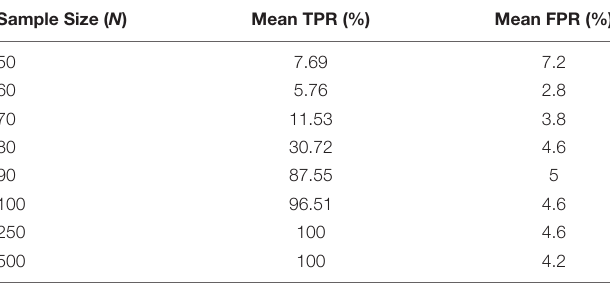
TABLE 1 | Overall true positive rate (TPR) and false positive rate (FPR) of CaDrA based on simulated data. Sample Size ( N )